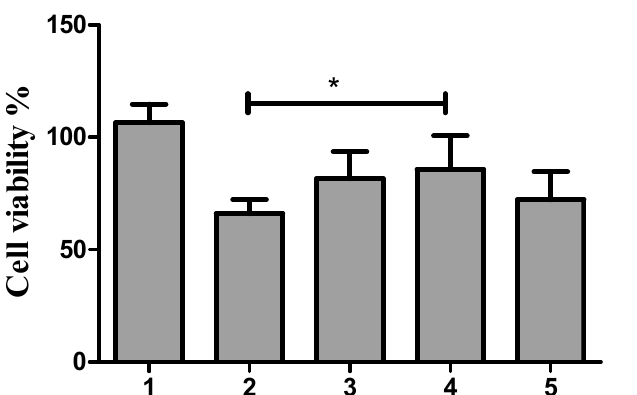
Figure 9. Cell viability assay with Dox-loaded ABN-SPDP in the presence of endocytosis inhibitors 24 h post-treatment in MCF-7 cells. 1: control, 2: ABN-SPDP Dox without endocytosis inhibitors, 3: in the presence of genistein, 4: filipin, and 5: chlorpromazine. Statistical analysis was performed using one-way ANOVA Tukey’s test (* p -value <